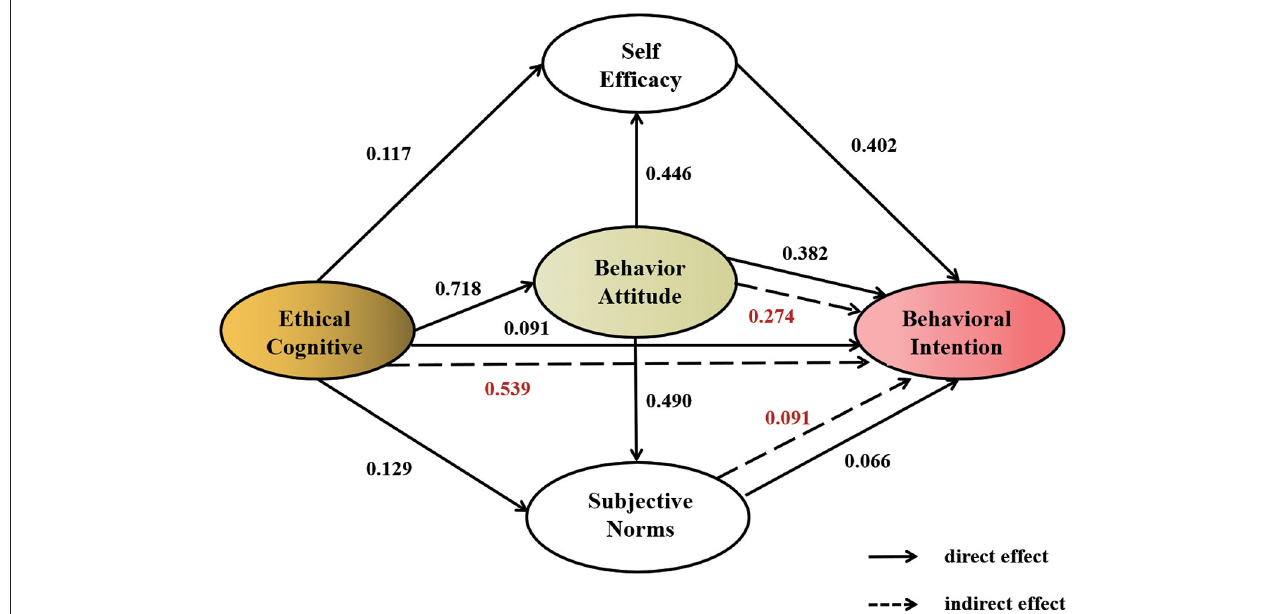
FIGURE 2 | Influence pathway model of behavioral intentions to care for COVID-19 patients.